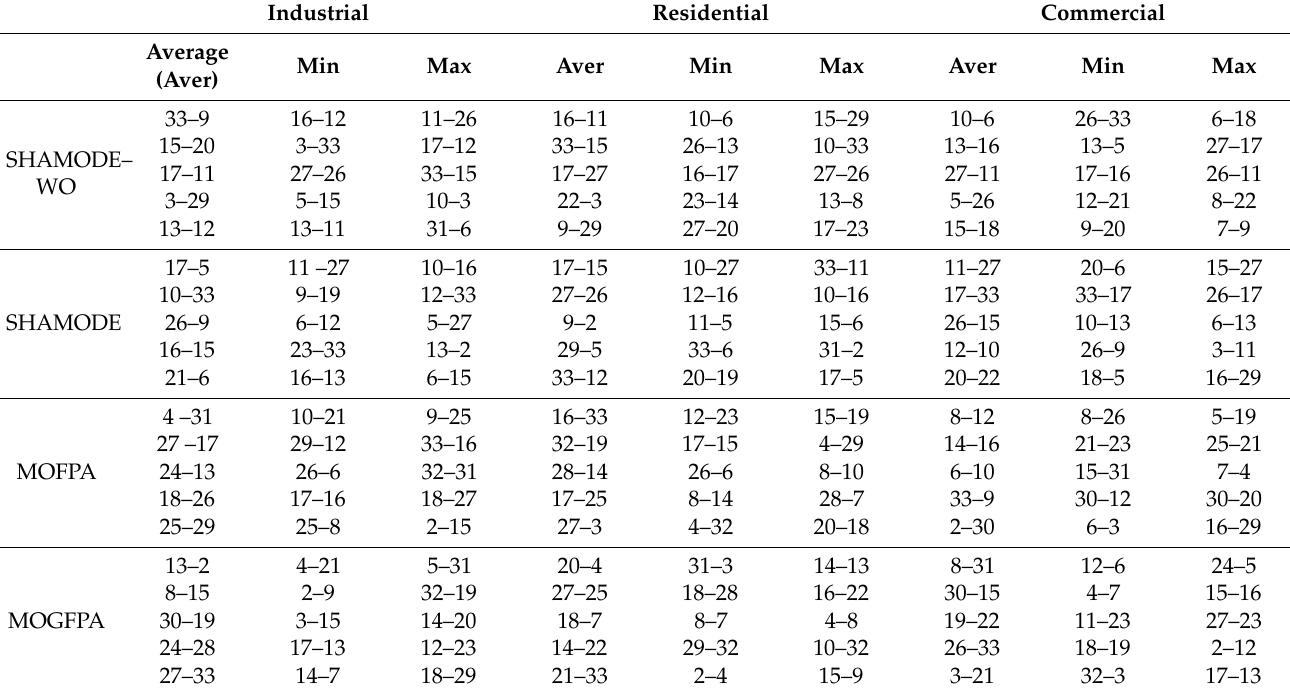
Table 2. Tie switches configuration for IEEE 33 bus system.